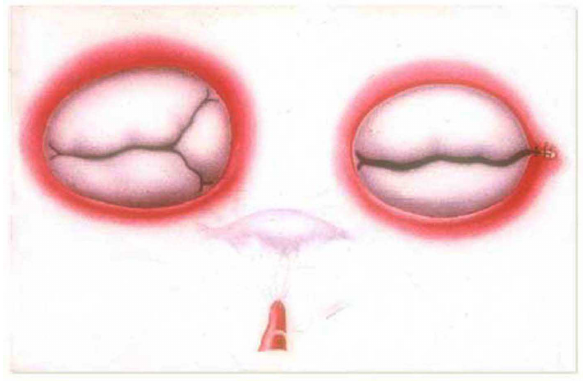
Fig. 3 – Removal of the posterior leaflet of the tricuspid valve, rendering it bicuspid. The specimen (lower) containing the leaflet, chordae tendineae, and the papillary muscle will be transferred to the mitral valve